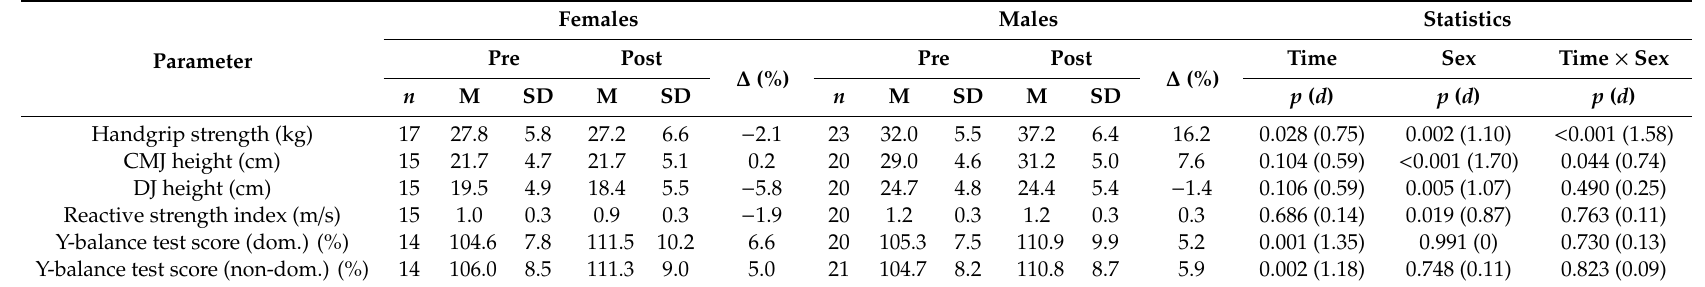
Table 2. Changes in physical fitness measures in young male and female judo athletes. Females Parameter